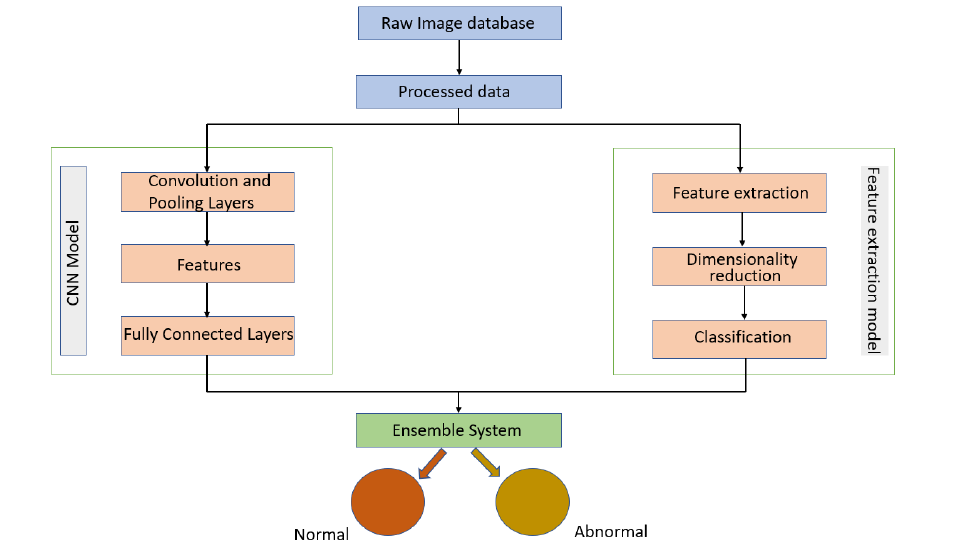
Figure 8. Diagram of the ensemble approach with a CNN and feature extraction for breast cancer detection proposed in